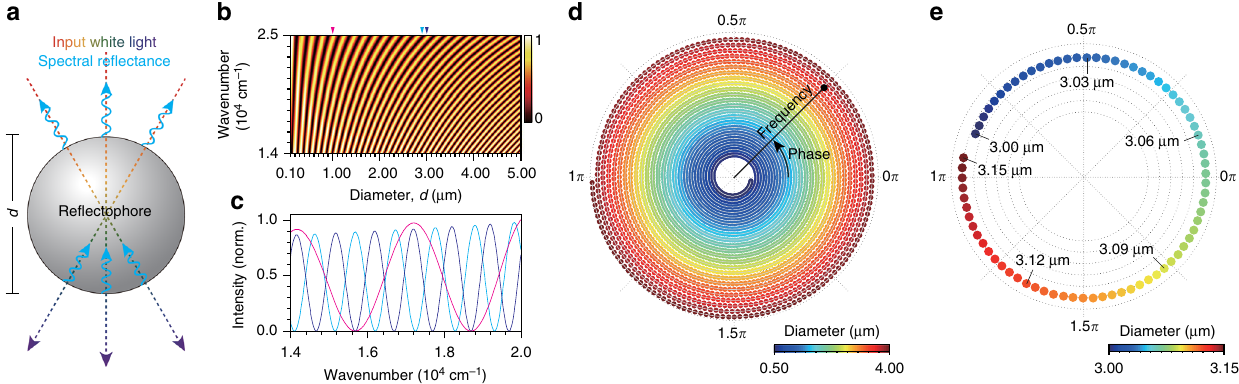
Fig. 1 Concept of re fl ectophore. a Schematic representation of a re fl ectophore. A dielectric microsphere can serve as a re fl ectophore through Fresnel re fl ections and interference from a broadband input source. Each re fl ectophore is distinguishable by its re fl ectance spectrum, which encodes its diameter ( d ) with nanoscale precision. b Simulated re fl ectance spectra of polystyrene-based re fl ectophores. Colorbar, normalized re fl ectance. c Representative simulated re fl ectance spectra of the polystyrene-based re fl ectophores (magenta: 1.00 μ m, cyan: 2.90 μ m, and blue: 3.00 μ m). Note that their diameter is encoded in the frequency and phase of the re fl ectance spectrum. d Phasor representation of the simulated spectra in b . Angle and radial distance correspond to phase and frequency, respectively. Phase is set to 0 π at 500 nm. e A representative phasor representation for polystyrene-based re fl ectophores with diameters ranging from 3.00 to 3.15 μ m at an interval of 2